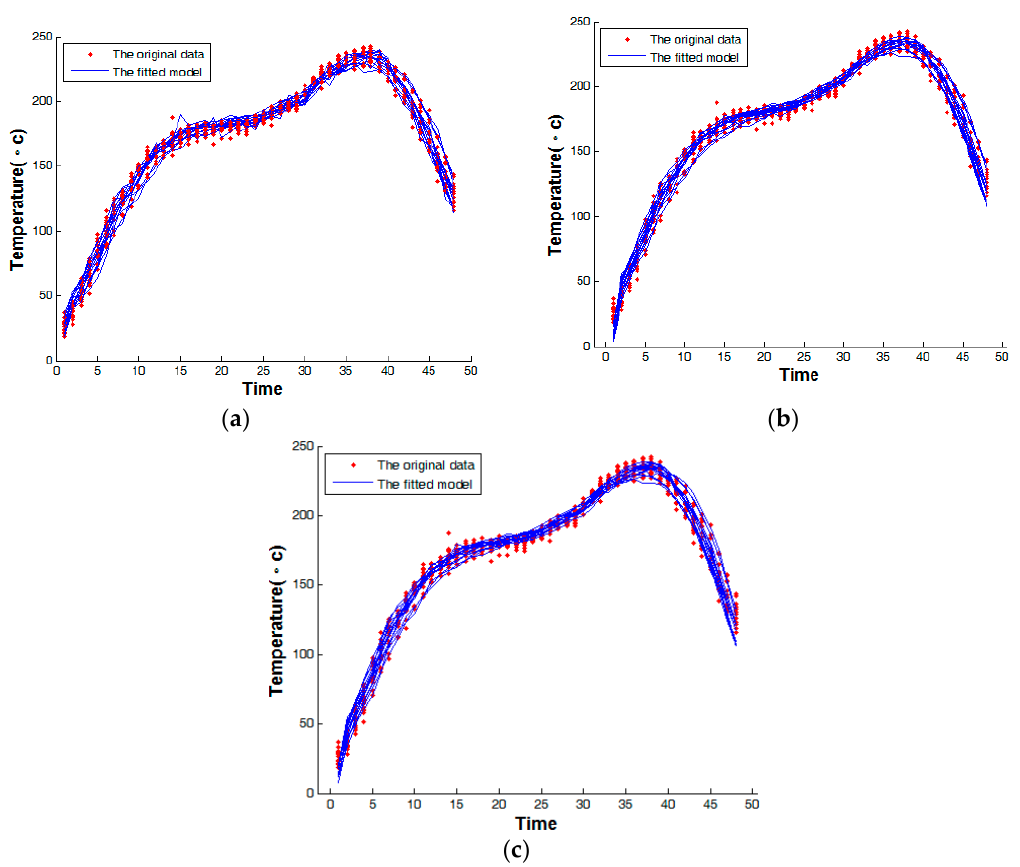
Figure 3. The fitting profile using the polynomial with AR(1) model. ( a ) The third-order model; ( b ) The fourth-order model; and, ( c ) The fifth-order model.